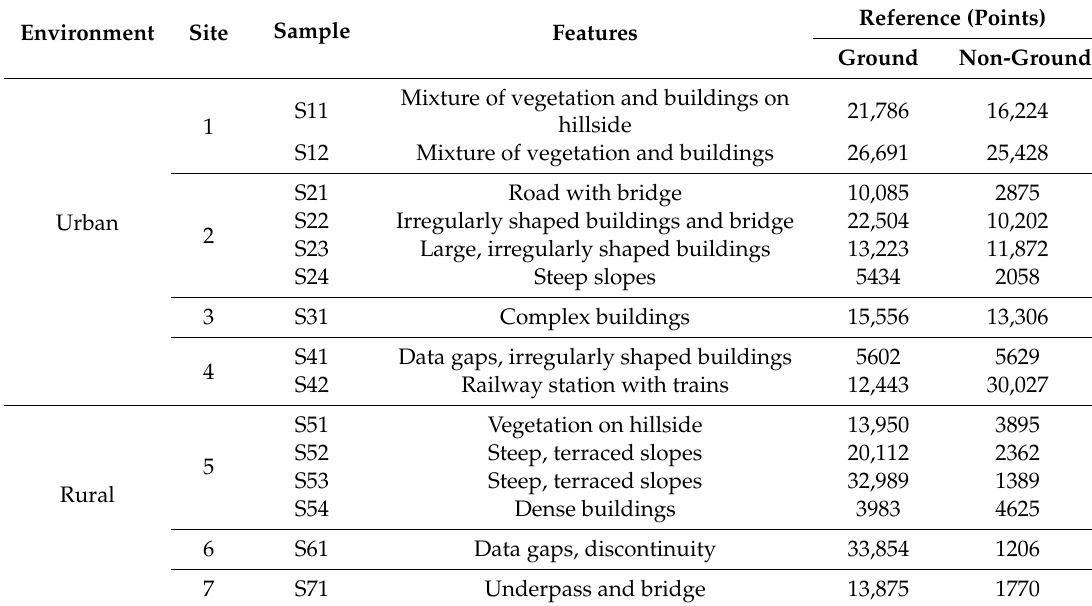
Table 1. Characteristics of each